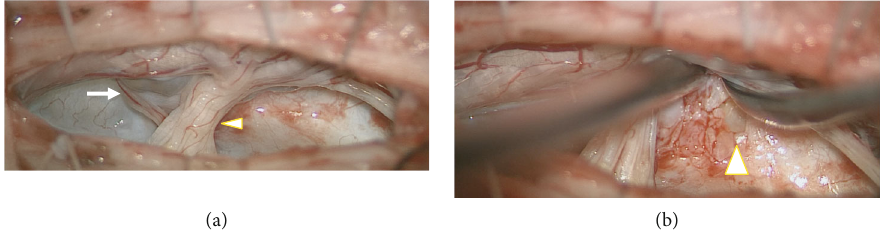
Figure 5: Intraoperative fi ndings. When the dura mater was incised at the C1-2 level, followed by incision in the denticulate ligaments on the right side of the spinal cord, a cystic lesion was present in the right C2 ventral root (arrowhead). The cyst (arrow), which caused compression and signi fi cant displacement of the cervical spinal cord from the right ventral side (a), was removed. The cyst capsule, however, seemed to remain in the ventral side and extend posterior to the odontoid process. We found that the dura mater was partly missing in the ventral side ((b) partially missing dura matter: